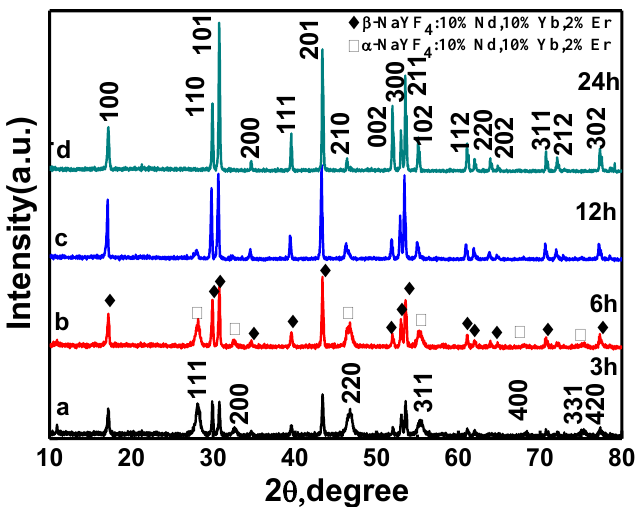
Figure 1. X-ray diffraction (XRD) patterns of NaYF microcrystals synthesized at different hydrothermal times: ( a ) 3 h; ( b ) 6 h; ( c ) 12 h; and